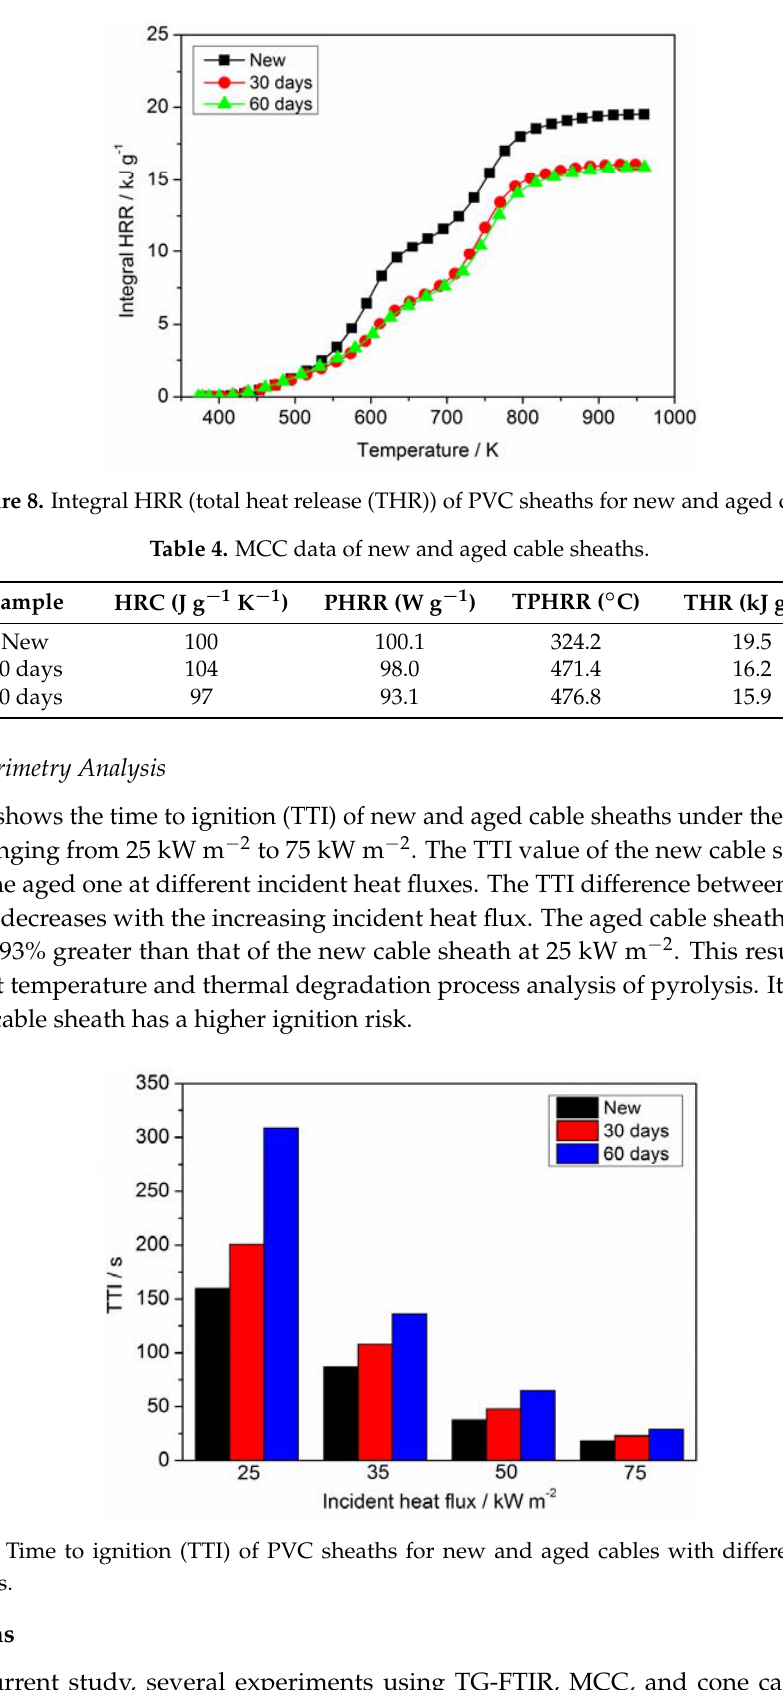
Figure 9. Time to ignition (TTI) of PVC sheaths for new and aged cables with different incident heat